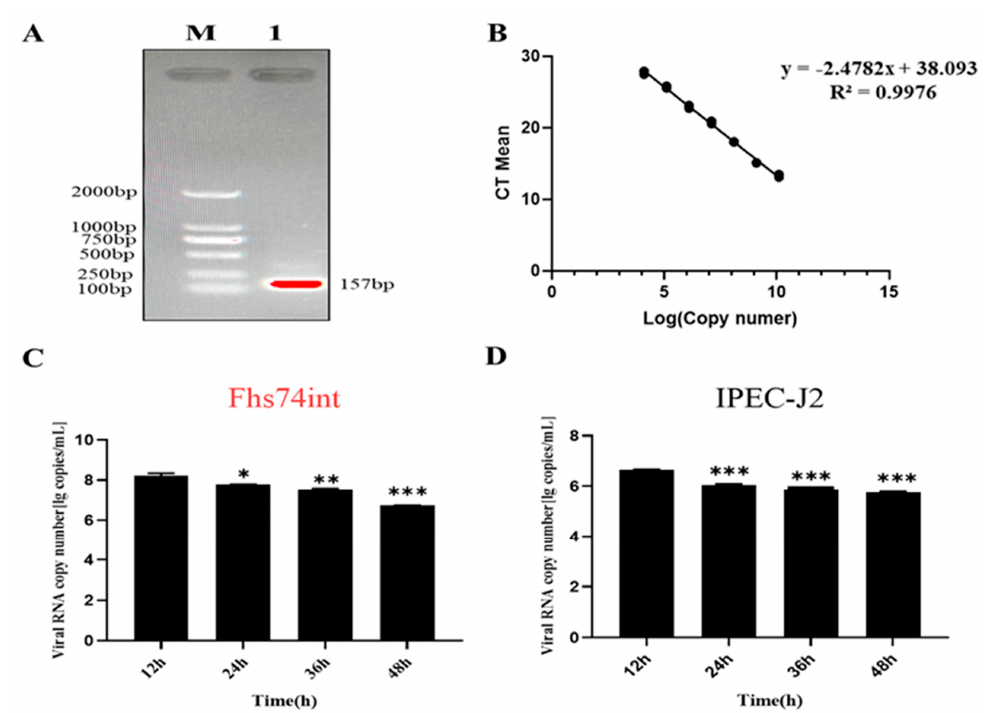
Figure 7. Expression levels of M genes at different time points in PEDV-infected IPEC-J2 cells and FHs 74 Int cells. ( A ) Amplification of PEDV M gene product by fluorescent primers. ( B ) Absolute quantitative standard curve of PEDV M gene. ( C ) Expression of M gene in PEDV − infected FHs 74 Int cells. ( D ) Expression of M gene in PEDV-infected IPEC-J2 cells. (* p -value < 0.05; ** p -value < 0.01; *** p -value <